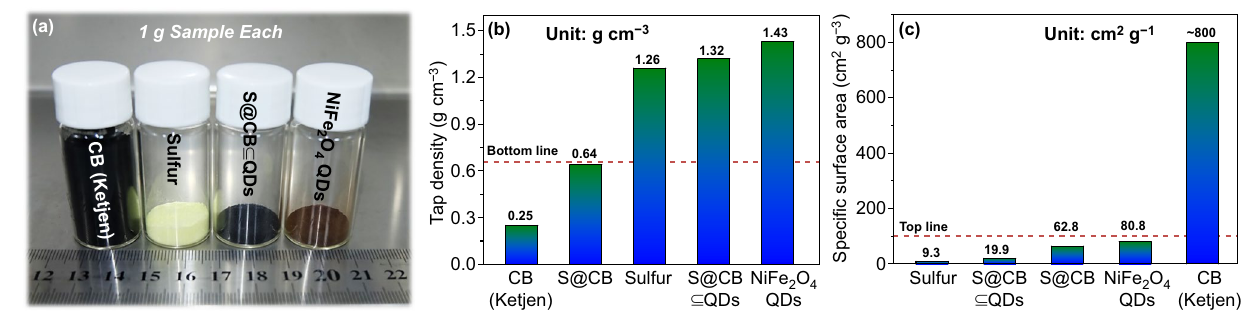
Fig. 3 a A visual photograph of 1 g pre-tapped CB, S, S@CB ⊆ QDs and NiFe 2 O 4 QDs powder samples. Parameter comparisons on the b tap density and c specific surface area of CB, S, S@CB, S@CB ⊆ QDs, and NiFe 2 O 4